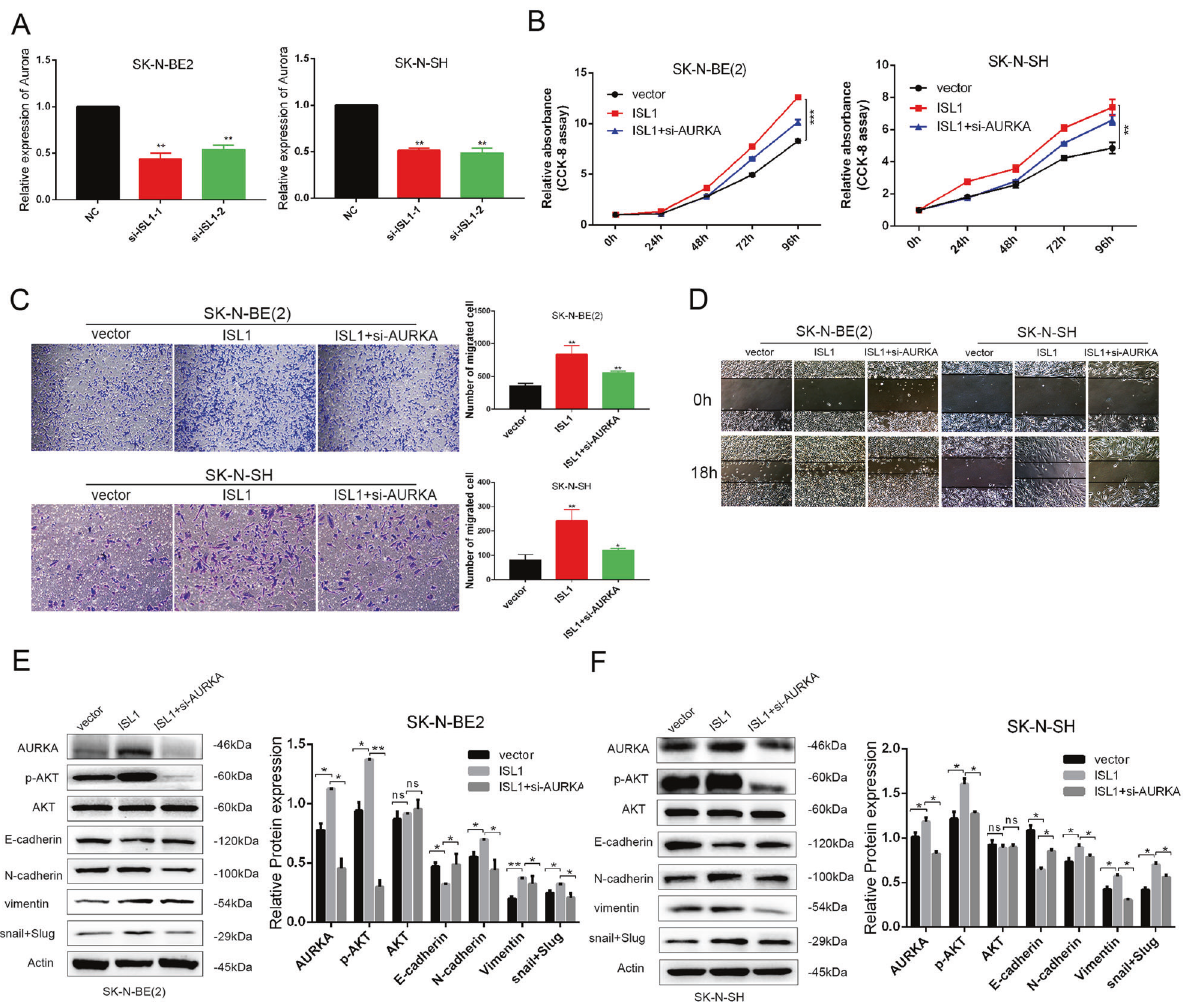
Fig. 8 Activation of PI3K/AKT pathway by ISL1 was depended on AURKA. A mRNA expression level of AURKA after knockdown of ISL1 in SK-N-BE (2) and SK-N-SH cells. B CCK8 proliferation assay of ISL-overexpressed-SK-N-BE (2) and ISL-overexpressed-SK-N-SH after knockdown of AURKA with si-AURKA. C Comparison of the invasion capacity in ISL-overexpressed-SK-N-BE (2) and ISL-overexpressed-SK-N-SH after knockdown of AURKA with or without si-AURKA. D Comparison of the migration capacity in ISL-overexpressed-SK-N-BE (2) and ISL-overexpressed-SK-N-SH after knockdown of AURKA with or without si-AURKA. E , F Comparison of ISL1, AKT, p-AKT protein, and EMT- associated markers expression in ISL-overexpressed-SK-N-BE (2) and ISL-overexpressed-SK-N-SH after knockdown of AURKA with or without si- AURKA (* P < 0.05, ** P < 0.01, *** P <